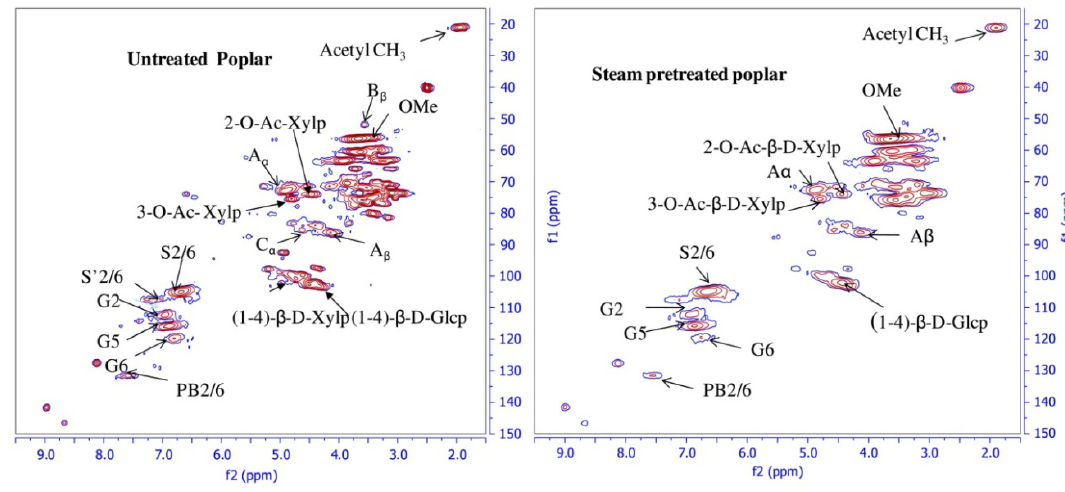
Figure 15. HSQC spectrum of untreated and pretreated poplar in perdeuterated pyridinium chloride-DMSO- d system (Reprinted from [82]. Copyright 2011 6